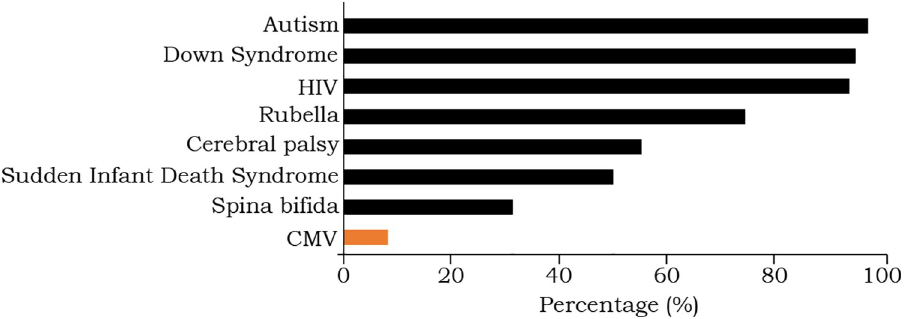
Fig 1. Survey respondents’ knowledge and awareness of various medical